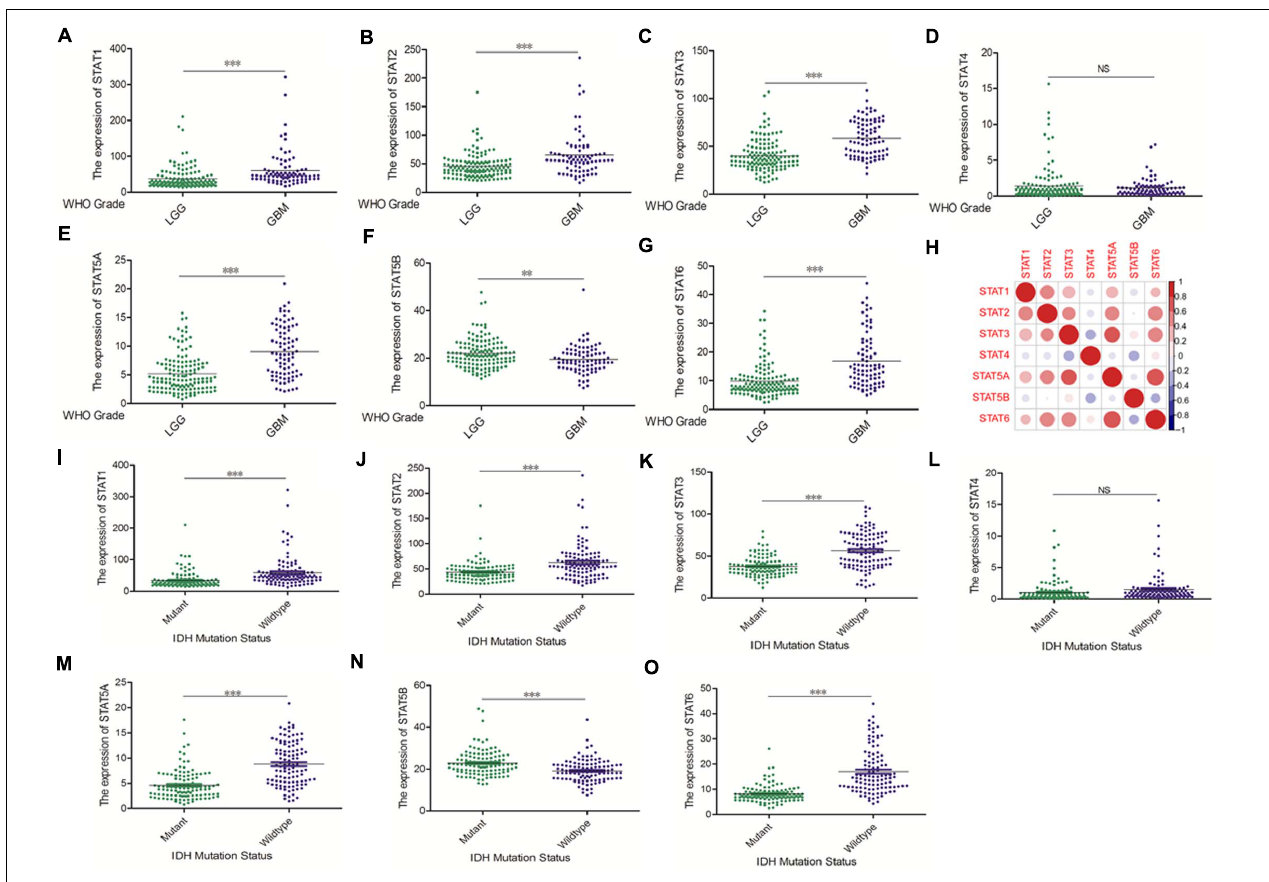
FIGURE 3 | mRNA expression levels of STATs in glioma (CGGA). (A–G) mRNA expression levels of STAT genes in LGG and GBM using CGGA database ( ∗∗ p < 0.01, and ∗∗∗ p < 0.001). (H) Co-expression heat map of STAT genes in glioma using CGGA database. (I–O) The correlation between STAT gene expression and IDH mutation status in glioma using CGGA database ( ∗∗ p < 0.01 and ∗∗∗ p < 0.001). “NS” means “not significant” or “not statistically significant,” i.e., p ≥